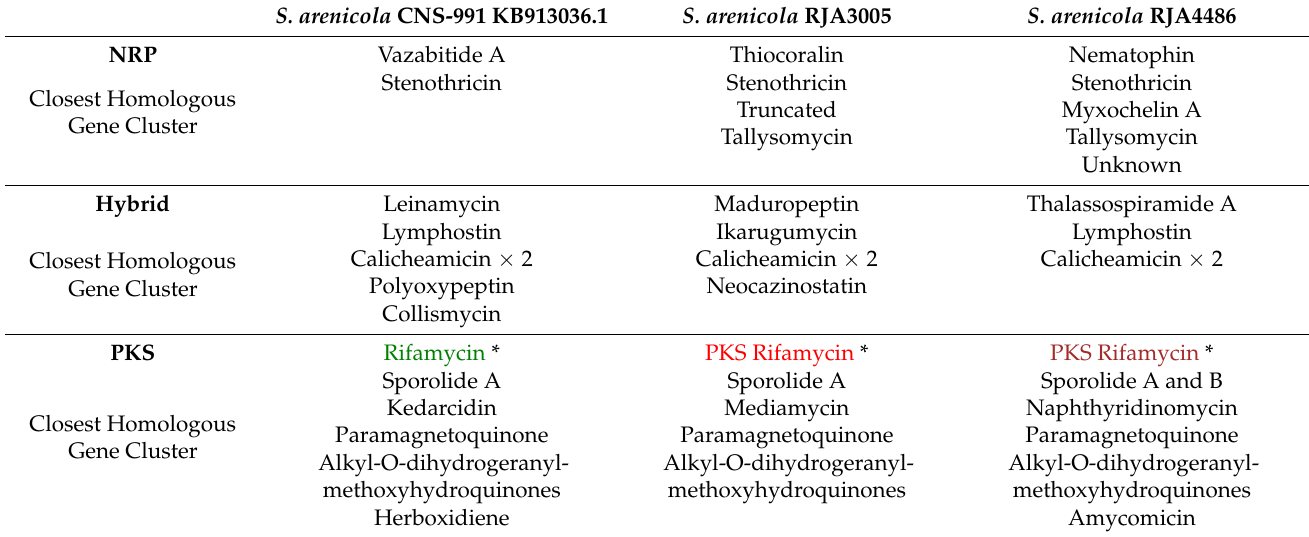
Table 3. Closest Homologous NRP, PKS, and Hybrid Gene Clusters for S. arenicola Strains. S. arenicola CNS-991